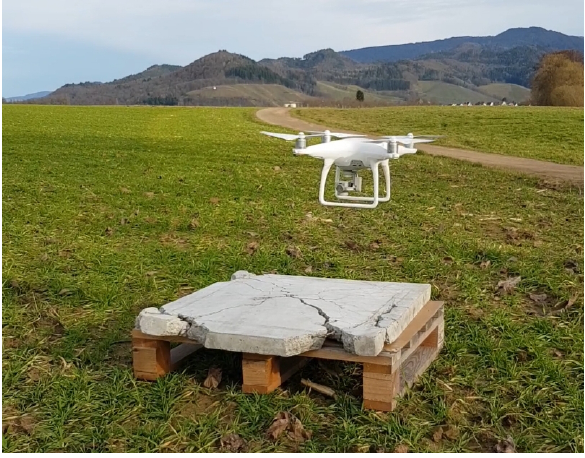
Figure 14. DJI Phantom 4 drone based capturing of test plate.